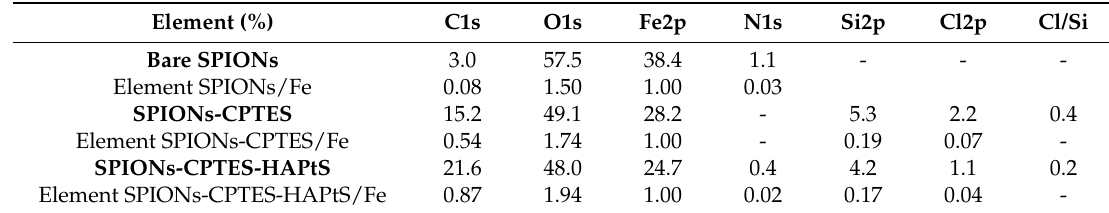
Table 4. XPS elemental analysis of bare and functionalized SPIONs (atomic